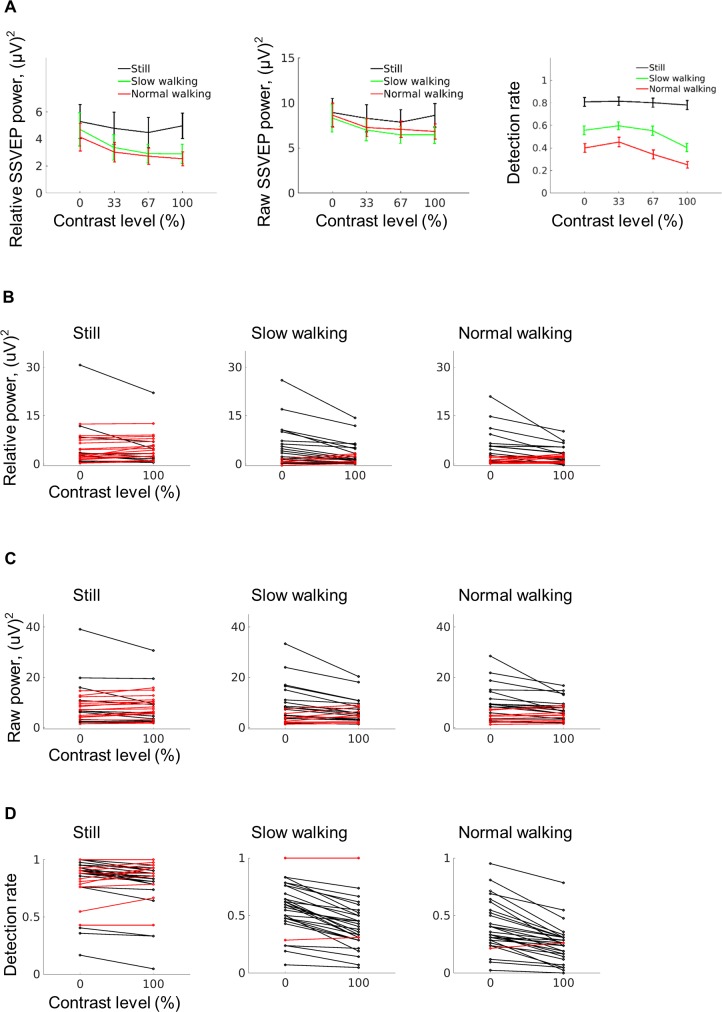
Influence of surround contrast depends on movement state.(A) SSVEP responses (left: referenced SSVEP power; middle: raw SSVEP power) and detection rates (right) significantly decreased with higher surround contrast levels during walking but not during standing still. Vertical lines indicate ±1 standard error, n = 25 (SSVEP); n = 30 (detection rate). Refer to S1 Table for break-down statistics. (B,C) Individual data from contrast level 0% and 100% for referenced SSVEP power and raw SSVEP power. Red lines indicate participants whose data patterns do not conform to suppression (detection rate at 100% contrast larger or equal to 0% contrast). (D) Same as B but showing the individual detection rate. The original data are available from https://doi.org/10.6084/m9.figshare.9094742.v1. SSVEP, steady-state visual evoked potential.